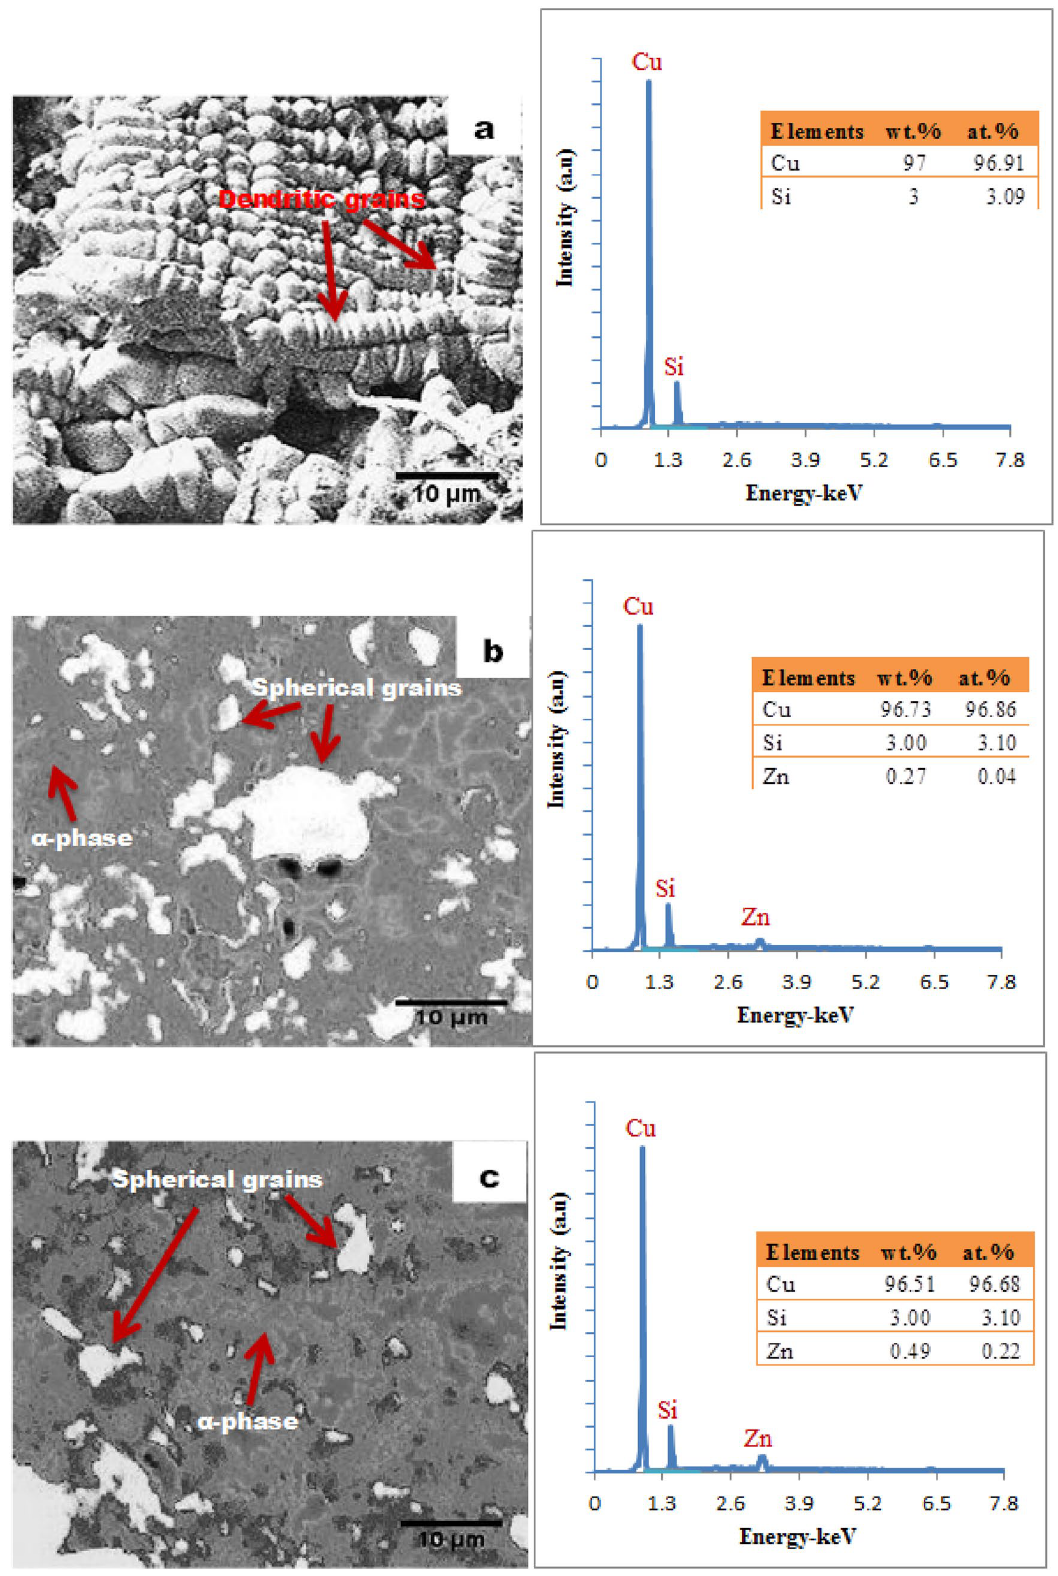
Fig. 5 SEM microstructure of silicon bronzes a Cu–3Si, b Cu–3Si–0.1Zn, c Cu–3Si–0.5Zn, d Cu–3Si–0.8Zn, and e Cu–3Si–1Zn and their corre- sponding EDS spectrum (Mag: